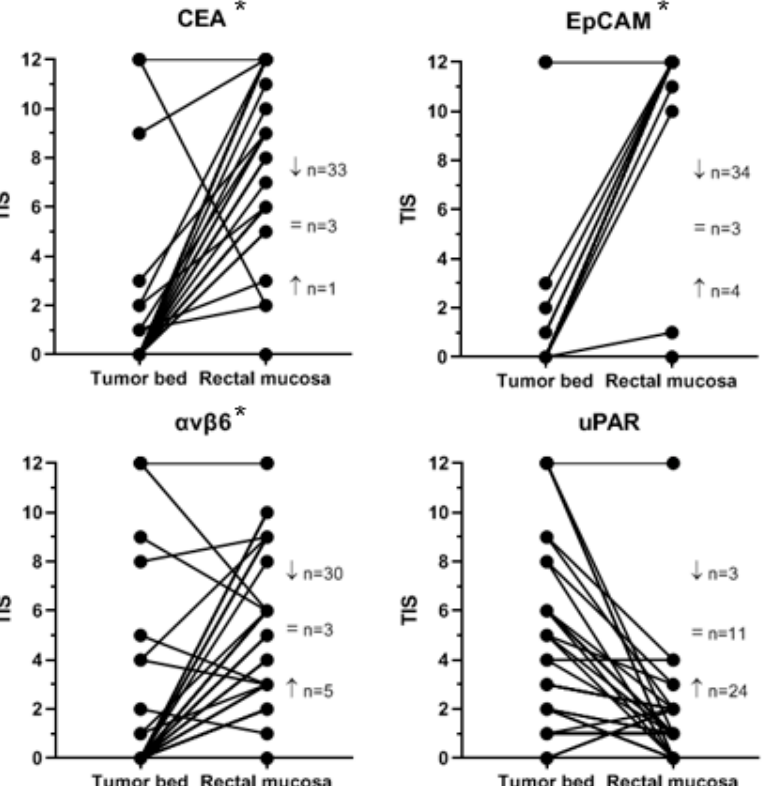
Figure 5. Target expression in the tumor bed compared to adjacent pre-existent rectal mucosa in resection specimens of pathological complete responders. Notes: Shown is the target expression (as TIS) in the pCR tumor bed compared to adjacent pre-existent rectal mucosa in the resection specimen, per patient and per target. Every line represents one or more patients. A horizontal line indicates the same level of expression in tumor bed and adjacent pre-existent mucosa. A descending or ascending line indicates respectively a higher or lower expression in the tumor bed compared with the adjacent pre-existent mucosa. The arrows indicate the number of tumor beds that show a decreased or enhanced expression compared with adjacent pre-existent mucosa; = refers to equal expression scores. The asterisks (*) indicate a significantly lower expression in the tumor bed compared with adjacent pre-existent rectal mucosa. Abbreviations: TIS, total immunostaining score; CEA, carcinoembryonic antigen; EpCAM, epithelial cell adhesion molecule; α v β 6, integrin α v β 6; uPAR, urokinase-type plasminogen activator receptor; pCR, pathological complete